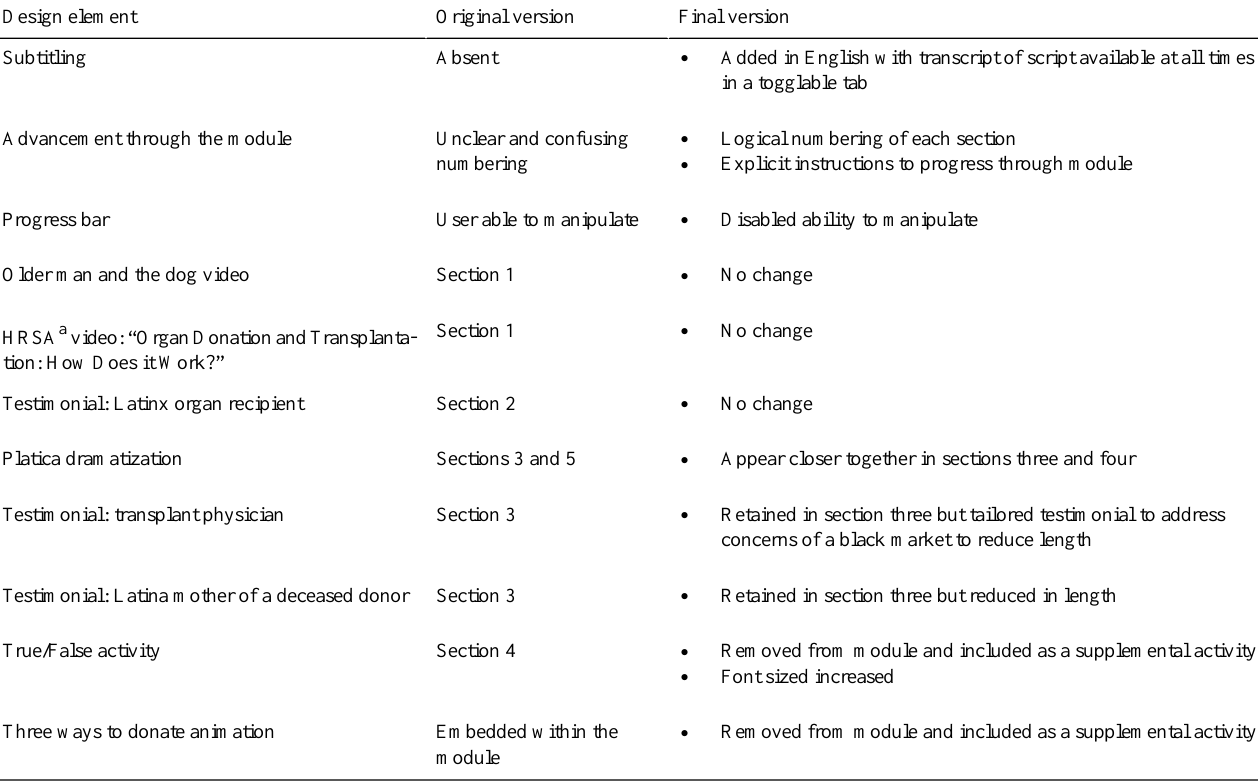
Table 4. Design elements in original and final versions of the